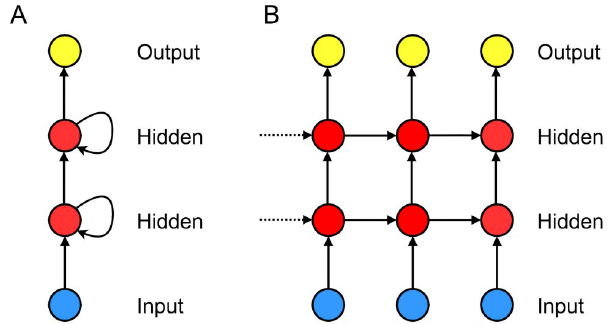
Fig 1. RNN architecture. An example RNN architecture with two hidden layers: A. a folded representation and B. an unfolded representation. The blue circles correspond to an input layer, the red circles correspond to hidden layers, and the yellow circles correspond to an output